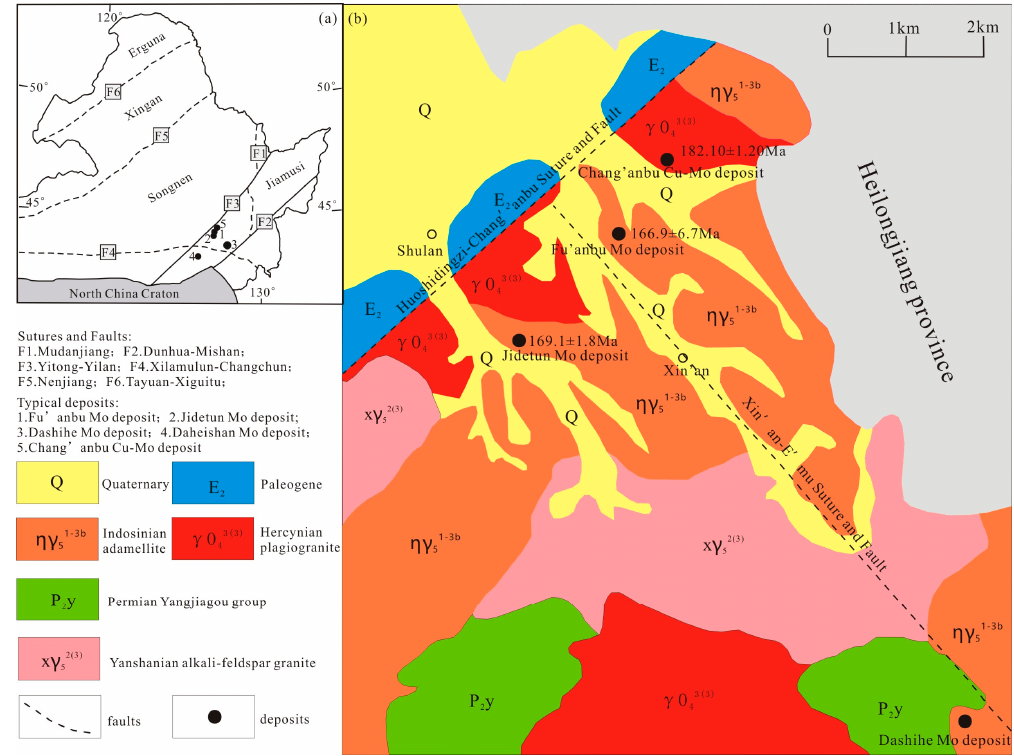
Figure 1. ( a ) Simplified tectonic map of the Shulan area and ( b ) geological map of the Shulan area (modified after [7]).